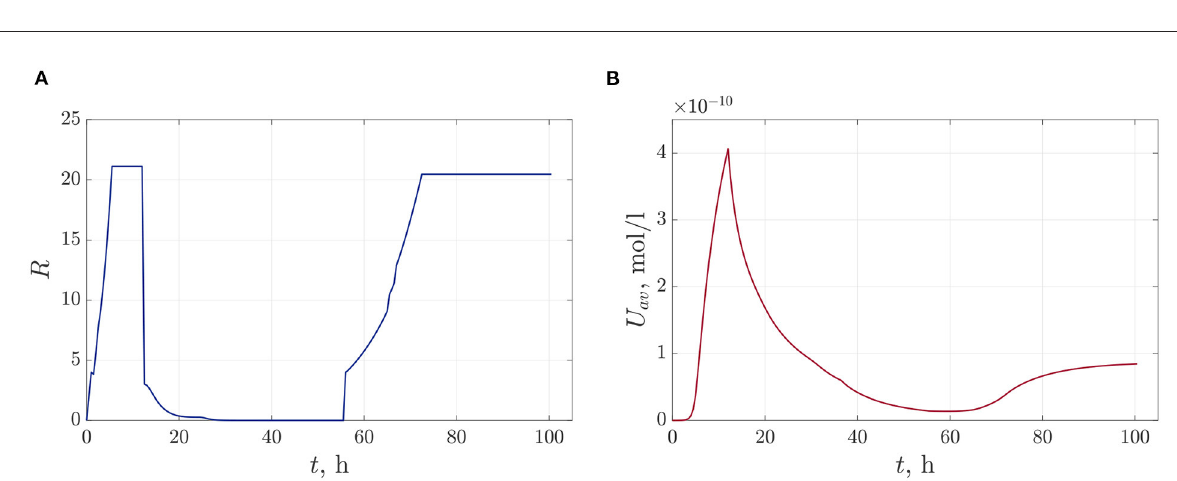
2 · 10 − 11 to 8 · 10 − 11 mol/l at t = t ob . It follows that the frequent use (within the considered range) of antibiotics does not confer treatment